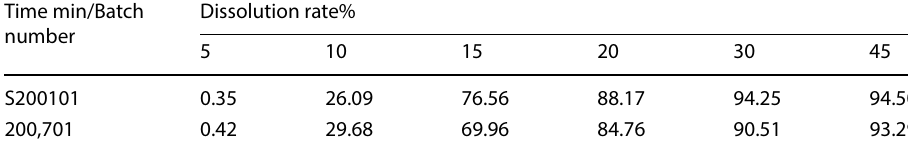
Table 8 Release comparison